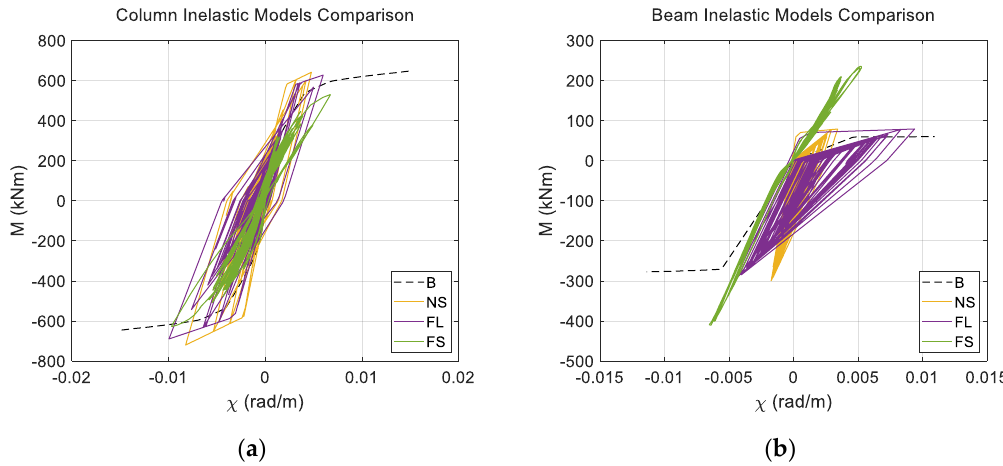
Figure 4. Inelastic models comparison for ( a ) columns and ( b ) beams elements.